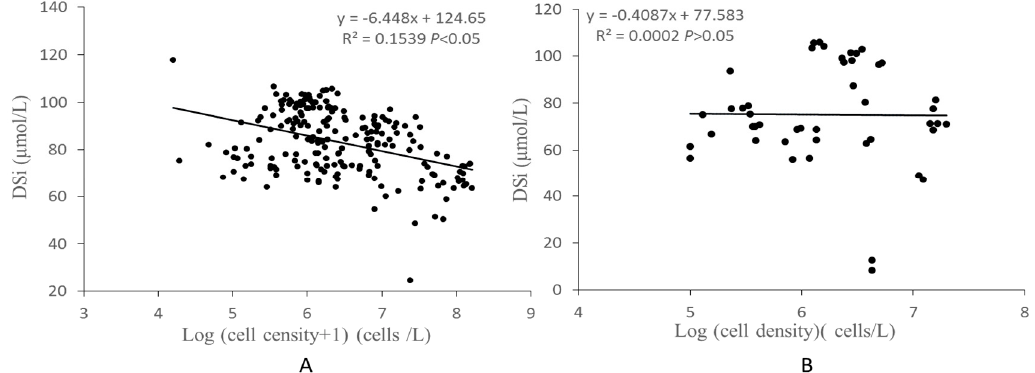
Figure 5. Relationships between diatom cell density and DSi in the lacustrine zone ( A ) and riverine